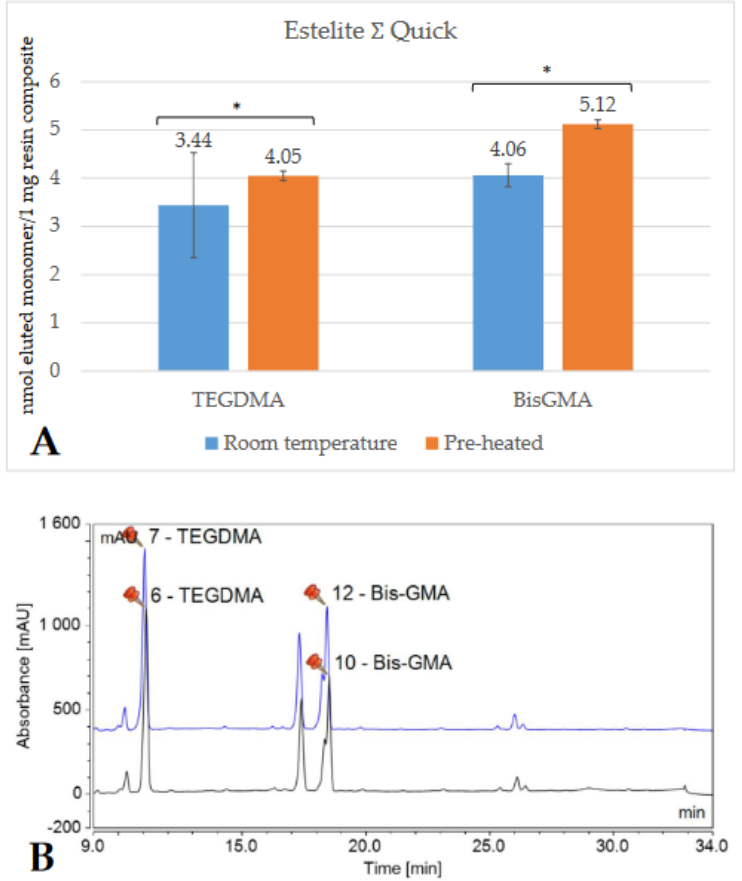
Figure 6. Comparison ( A ) of the amount of eluted monomers from room-temperature (blue bars) and pre-heated (orange bars) Estelite Ʃ Quick samples. The * mark indicates statistically significant differences between the groups according to the independent two-tailed t -test. The chromatogram ( B ) shows the detected monomers eluting from room-temperature (black chromatogram) and pre-heated (blue chromatogram) Estelite Ʃ Quick and their retention times based on the standard monomers, evaluated at a 205 nm wavelength. (Abbreviations: TEGDMA, trietylene-glycol-dimethacrylate; BisGMA, bisphenol A-glycidyl methacrylate; mAU, milli-Absorbance Units).